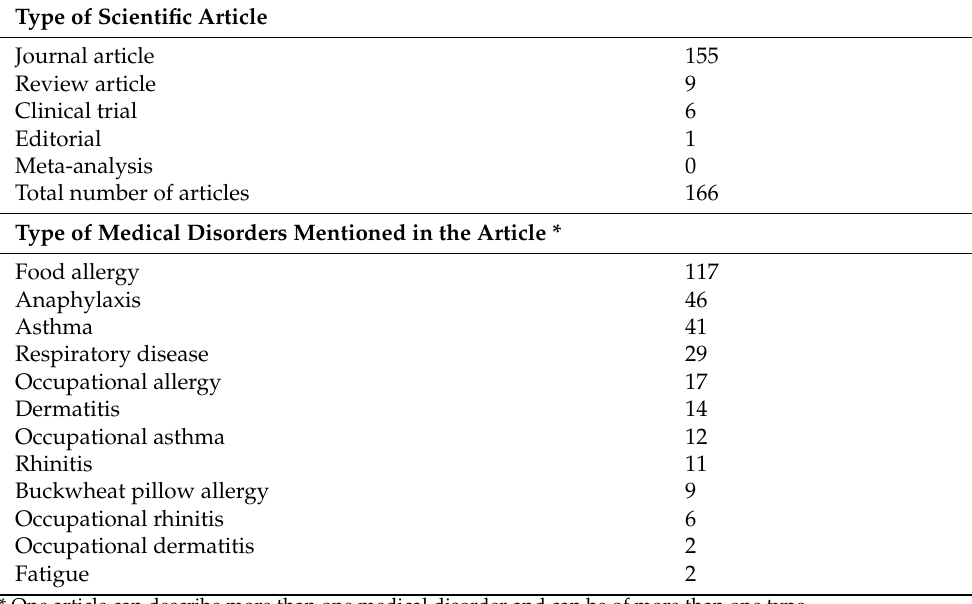
Table 1. The total number of articles (N = 166), and types of articles identified in PubMed from 1970–2020 by the search term “buckwheat